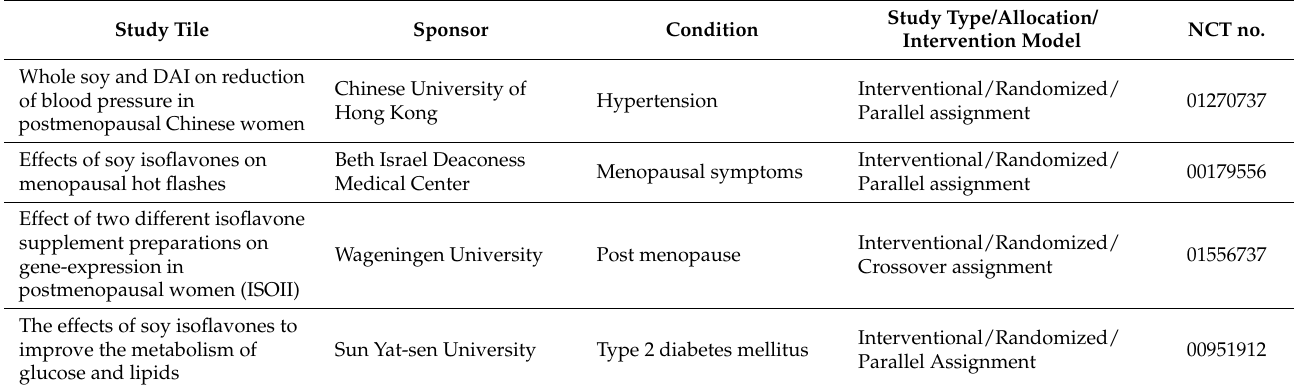
Table 4. The state-of-the-art about clinical trial status related to DAI and its therapeutic